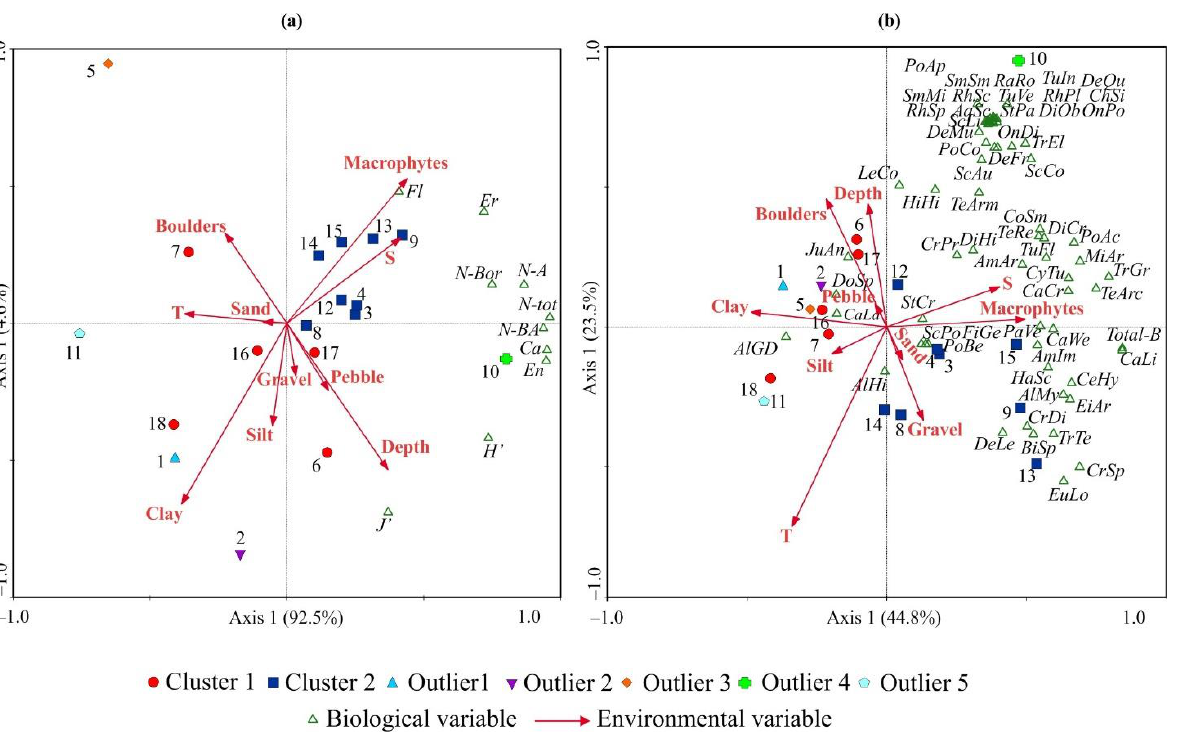
Figure 6. Ordination triplots of samples by redundancy analysis with respect to bryozoan diversity ( a ) and biomass ( b ) and their relations to environmental variables in Grønfjorden. The proportions of the total variability explained by the first two axes are given. Biological variables: Biomass for each species (for species abbreviations see Table 1), Total-B — total biomass, Ca — number of calcified bryozoans, Fl — number of flexible bryozoans, En — number of encrusting bryozoans, Er — number of erect bryozoans, N-Bor — number of boreal species, N-BA — number of Boreo-Arctic species, N-A — number of Arctic species, N-Tot — total number of species, En — number of encrusting species, Er — number of erect species, Ca — number of calcified species, Fl —number of flexible species, H′—Shannon index, J′—Pielou’s evenness. Environmental variables: T— temperature (°C), S — salinity, Depth — depth (m), Clay, Silt, Sand, Gravel, Pebbles, Boulders, Macrophytes — proportions of corre-